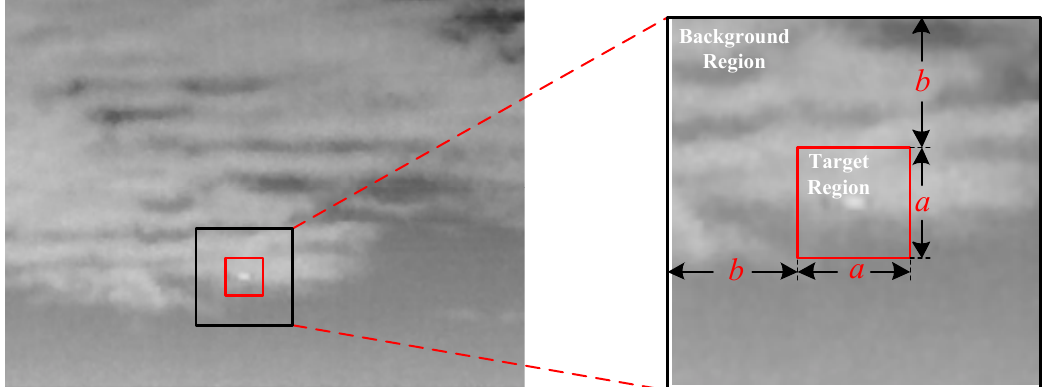
Figure 6. Neighborhood defined by SCR Gain and BSF.